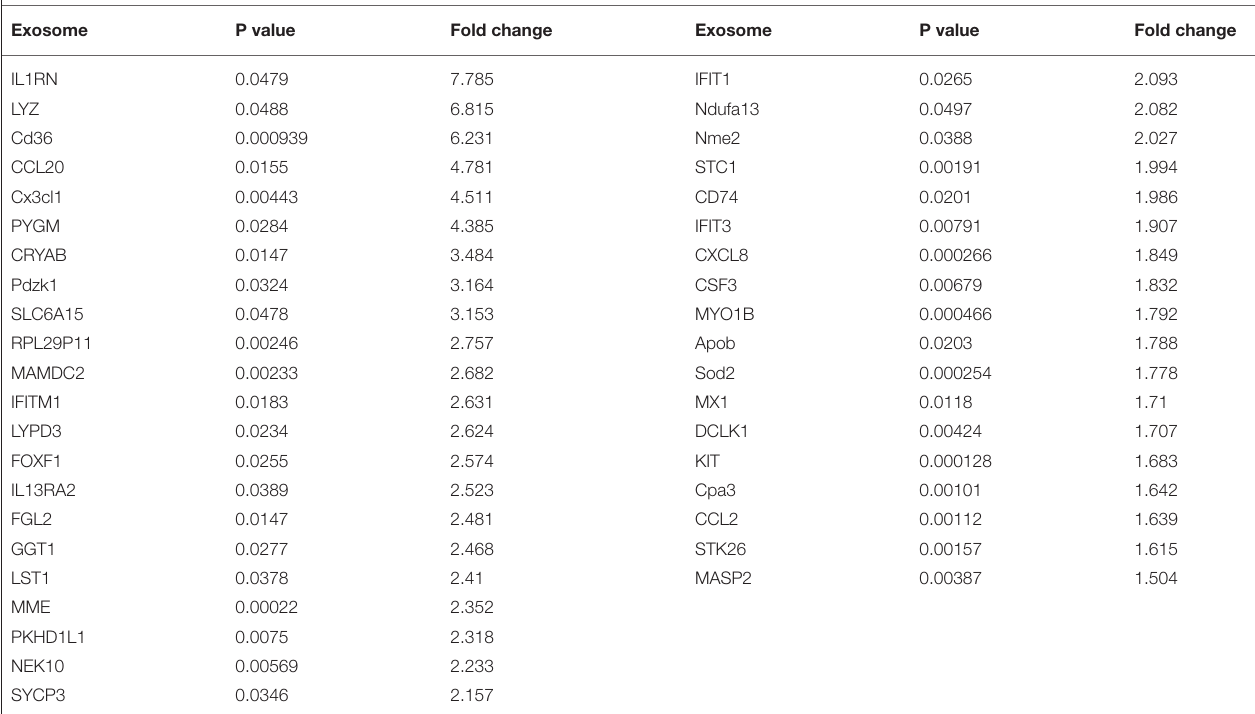
FIGURE 4 | LPIs significantly upregulate secretomic genes of canonical secretomes, non-canonical caspase-1-Gasdermin D (GSDMD), caspase-4-GSDMD, and exosome secretomes in HAECs. (A) Among 2,640 canonical secretomes, 216 were significantly upregulated in LPI-treated HAECs. The upregulated genes accounted for 8.2% of the total canonical secretomes. (B) Sixty non-canonical caspase 1 dependent secretomes were significantly elevated in LPI-treated HAECs. (C) One hundred seventeen non-canonical caspase 4 dependent secretomes were dramatically increased in LPI-treated HAECs. (D) Forty exosomes were dramatically increased in LPI-stimulated HAECs. *Genes in (A–C) were selected with p < 0.05 and log 2 FC > I1I as significantly changed genes, while genes in exosome listed p < 0.05 and log 2 FC > |1.5| as significantly changed genes. The full list of 923 LPI-upregulated exosomes can be found in Supplementary Table S3 . *Created with